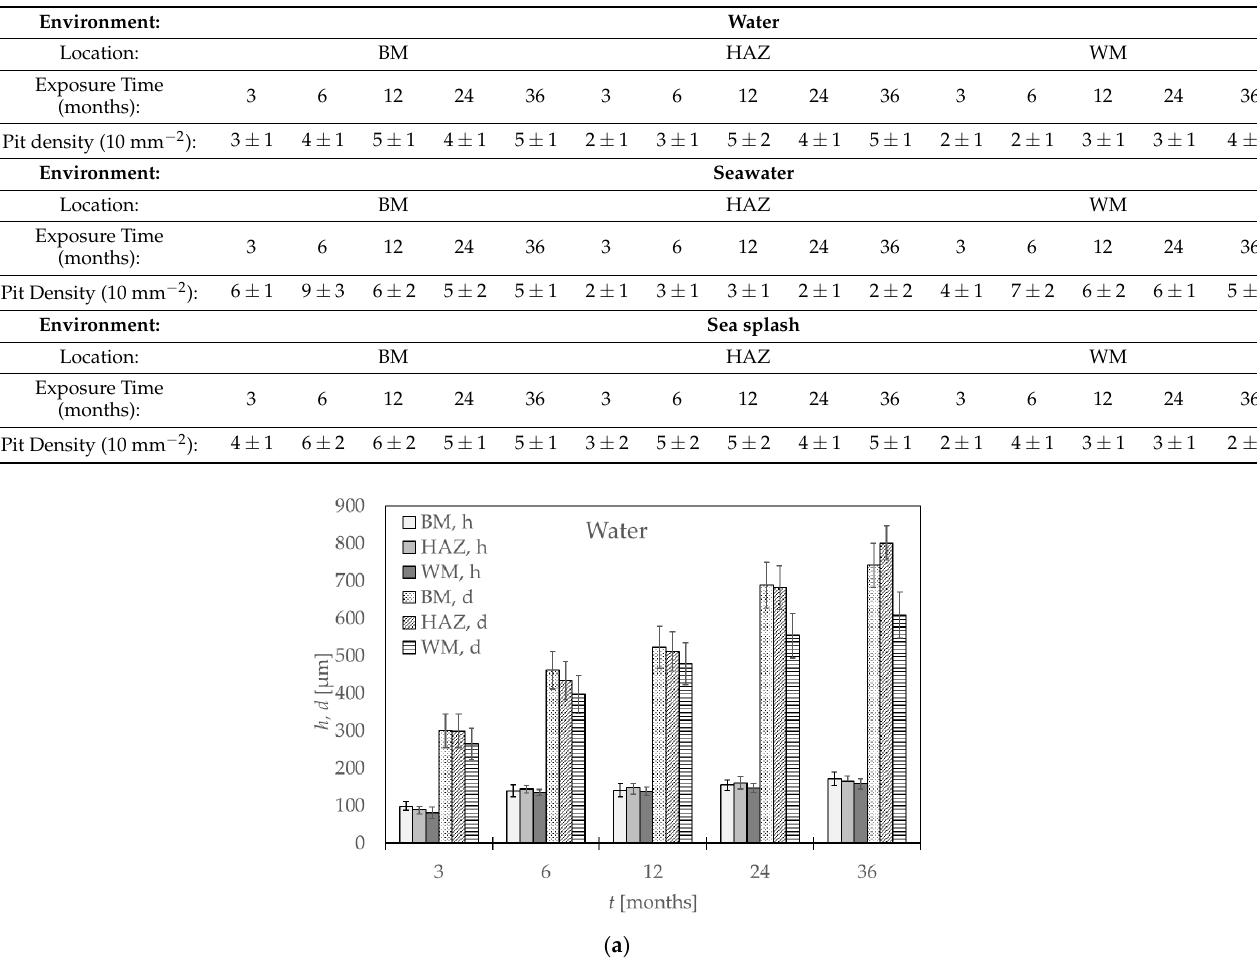
( b ) ( c ) Figure 7. Values of average pit depth ( h ) and pit diameter ( d ) of specimens over exposed time ( t ). ( a ) water, ( b ) sea water, ( c ) sea tide.